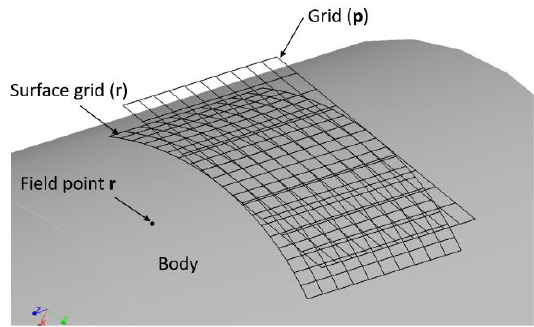
Figure 1. The contacting surface and the computational grid. The displacement u( r ij ; r ) of a field point r due to a load at the surface grid point r ij can be expressed as